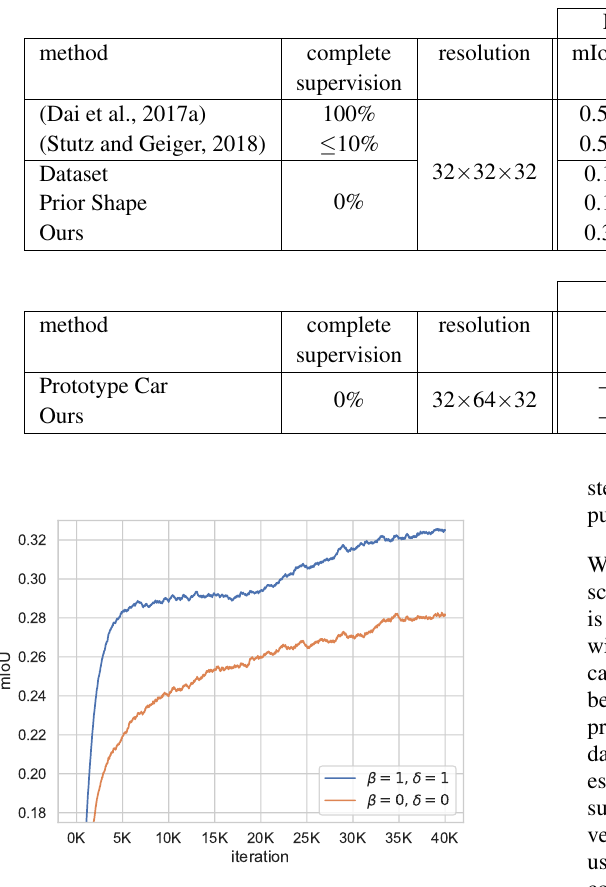
Figure 8. Ablation study showing the influence of the loss terms L GAN ( G ) and L feat ( G ) during